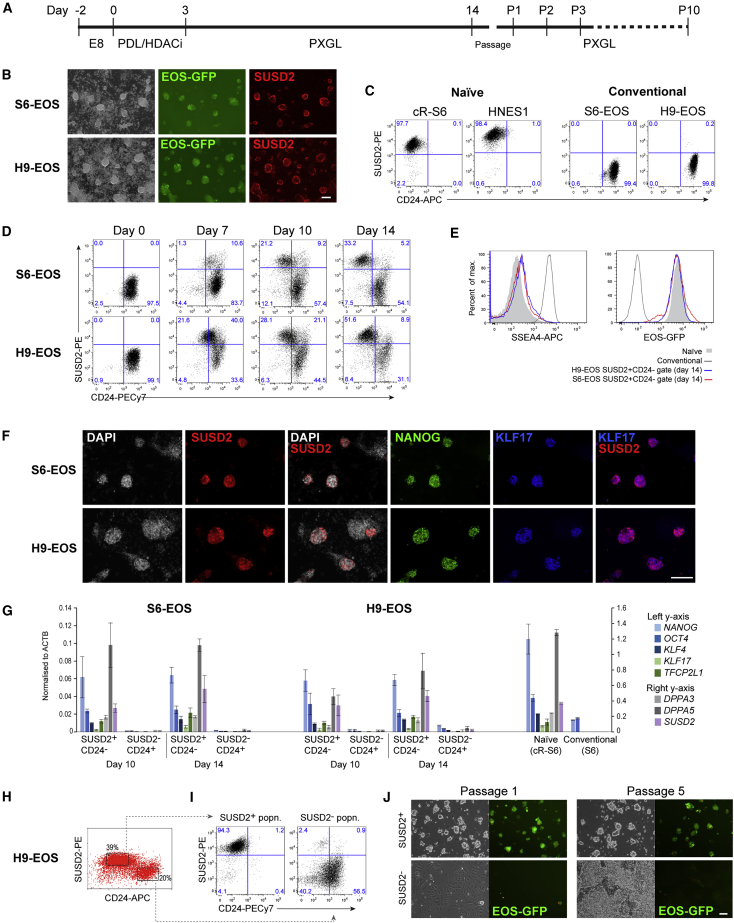
SUSD2 Identifies and Purifies Reset Naive hPSCs(A) Schematic of the chemical resetting protocol. HDACi, histone deacetylase inhibitor.(B) Images of cultures at day 10 of resetting. Scale bar, 50 μm.(C and D) Flow-cytometry analysis of SUSD2 and CD24 expression in conventional and naive hPSCs (C) and during resetting (D).(E) Flow-cytometry analysis of GFP and SSEA4 on SUSD2+CD24− cells at day 14 of resetting.(F) Immunostaining for SUSD2, NANOG, and KLF17 at day 14 of resetting. Scale bar, 100 μm.(G) qRT-PCR analysis of sorted SUSD2+CD24− and SUSD2−CD24+ cells at day 10 and day 14 of resetting. Error bars indicate SD of three independent experiments.(H) Flow cytometry sort plot at day 14 of resetting.(I) Flow-cytometry analysis of SUSD2 and CD24 expression on cell populations sorted in (H), 5 days after sorting. SUSD2+, SUSD2+CD24−; SUSD2−, SUSD2−CD24+.(J) Bright-field and GFP images of cell populations sorted in (H) at passages 1 and 5 after sorting. Scale bar, 50 μm.See also Figure S4.